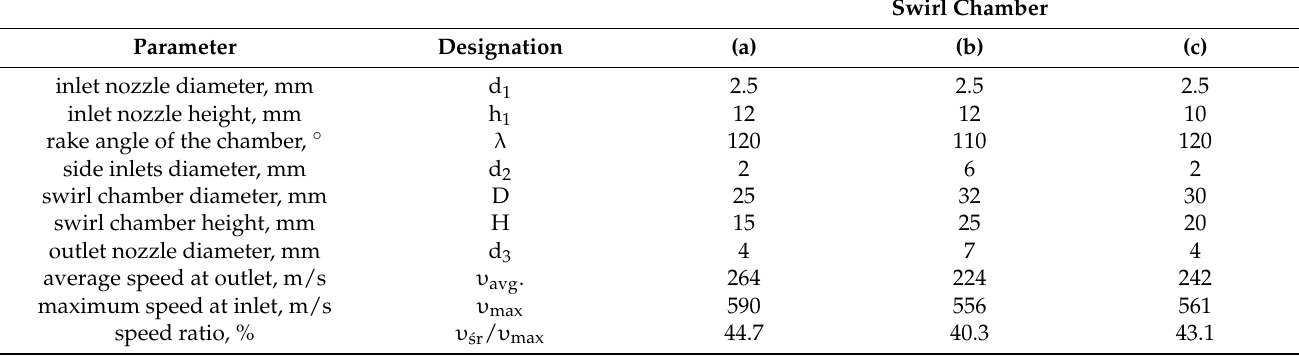
Table 2. Characteristics of the geometric dimensions and velocity of the water stream produced in the most favorable models of heads with side openings perpendicular to the swirl chamber. Models of Heads with Side Openings Perpendicular to the Swirl